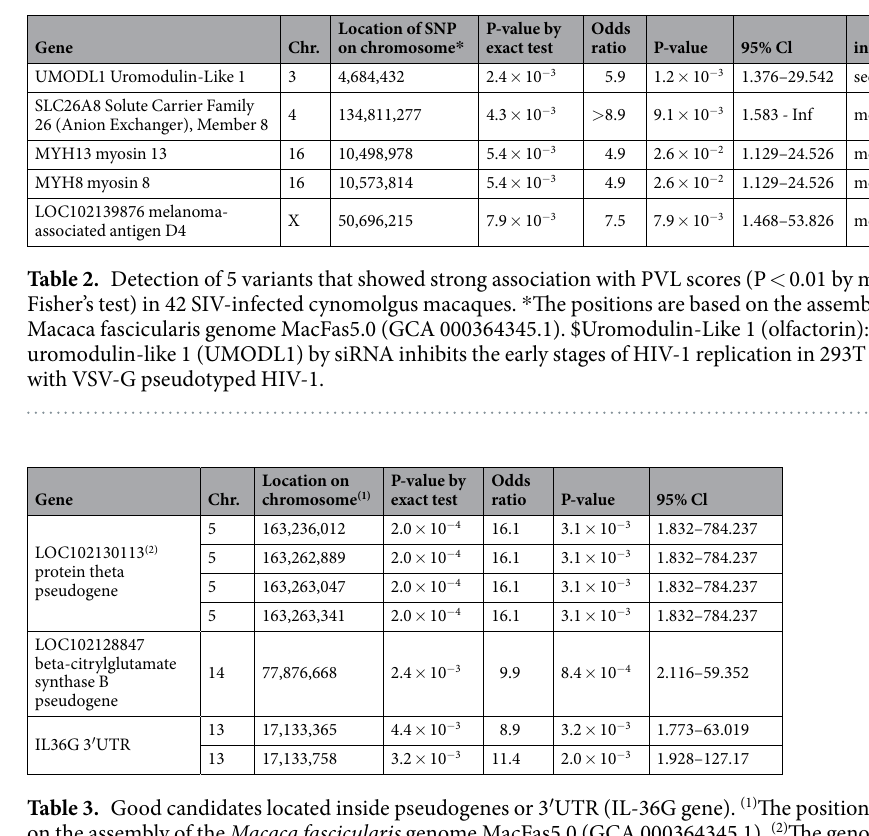
Table 3. Good candidates located inside pseudogenes or 3 ′ UTR (IL-36G gene). (1) The positions are based on the assembly of the Macaca fascicularis genome MacFas5.0 (GCA 000364345.1). (2) The genotypes of the 42 animals were strictly homologous (base of reference/variant) for the four candidate SNPs inside LOC102130113. Therefore, the p values and odds ratio are